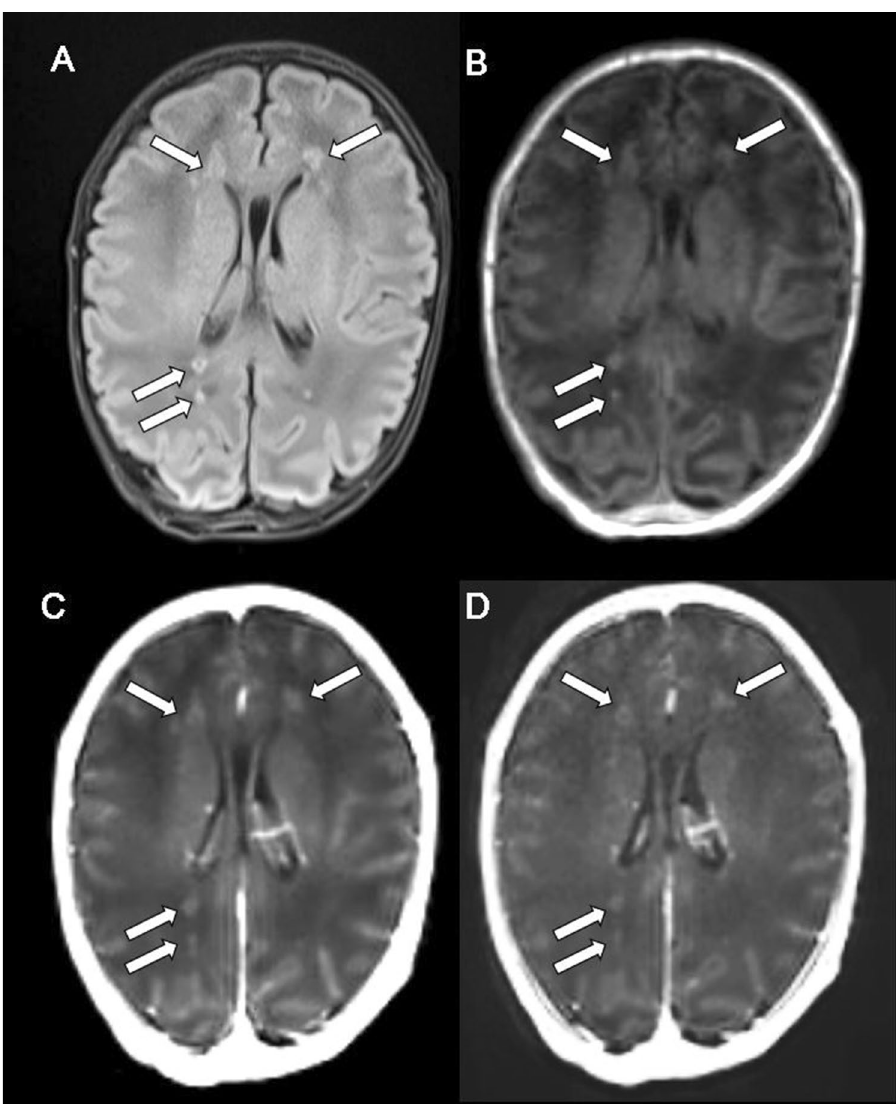
Multifocal FLAIR (A) and precontrast T1 MPRAGE (B) high signal intensity lesions without enhancement on both conventional MPRAGE (C) and wave-CAIPI MPRAGE (D) which suggest areas of hemorrhage are discovered in both periventricular white matter. The patient is diagnosed with periventricular